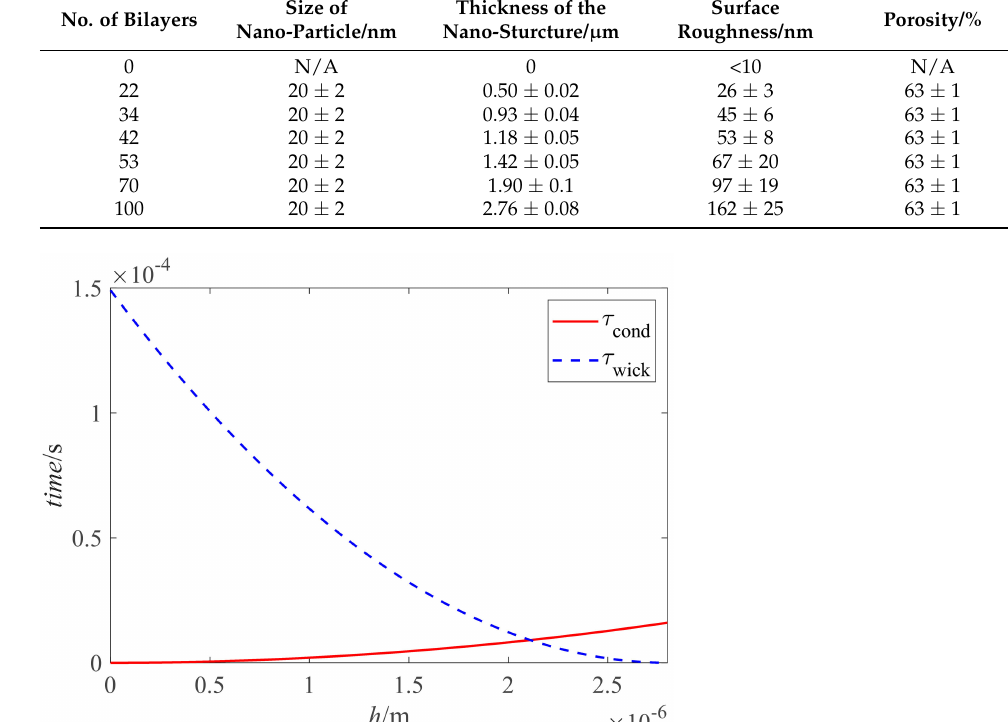
Figure 13. Variations of the τ cond and τ wick with height h on 100 bilayers LbL nano-structured surface.